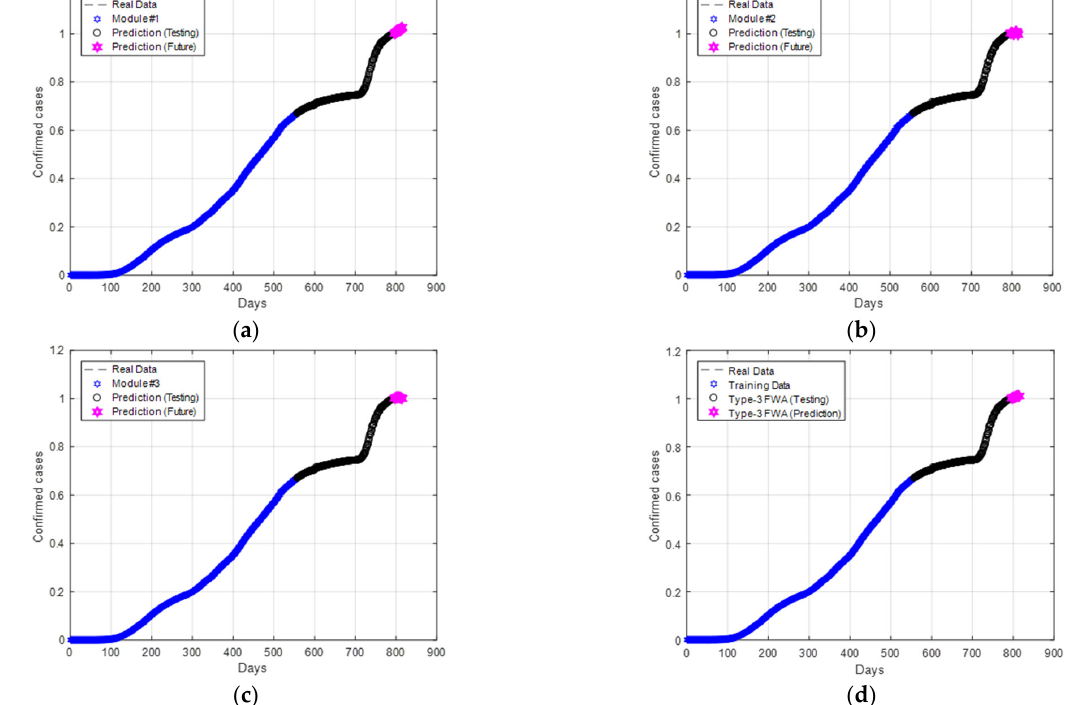
Figure 11. Individual behavior and final prediction for Brazil: ( a ) module #1; ( b ) module #2; ( c ) module #3; ( d ) final prediction.